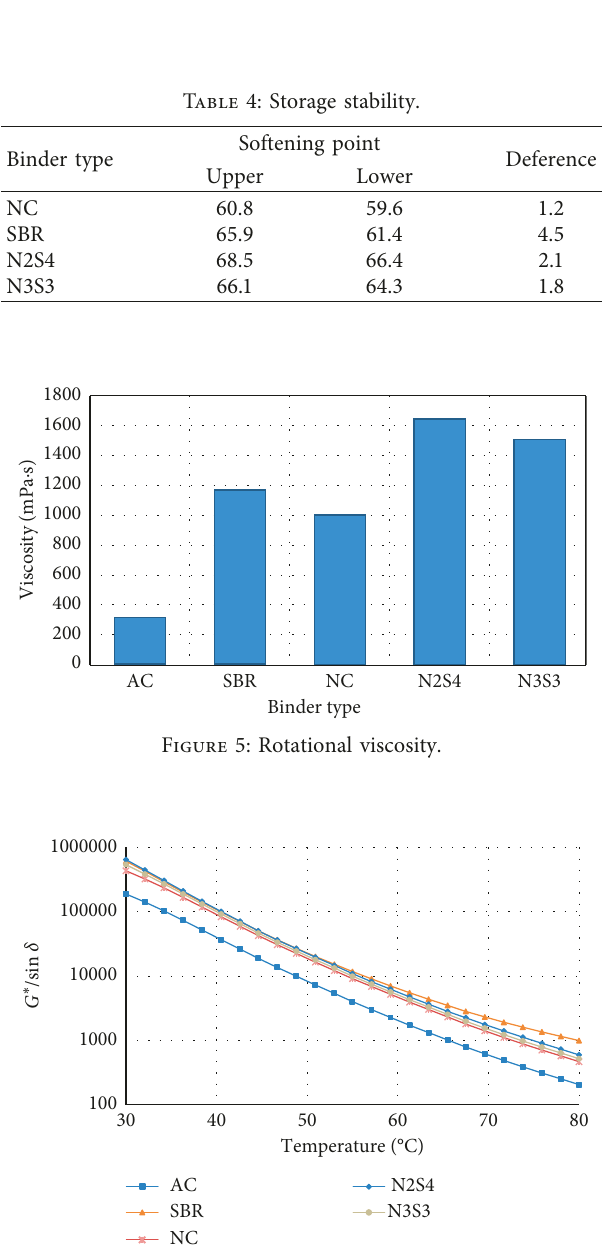
Figure 6: DSR test.